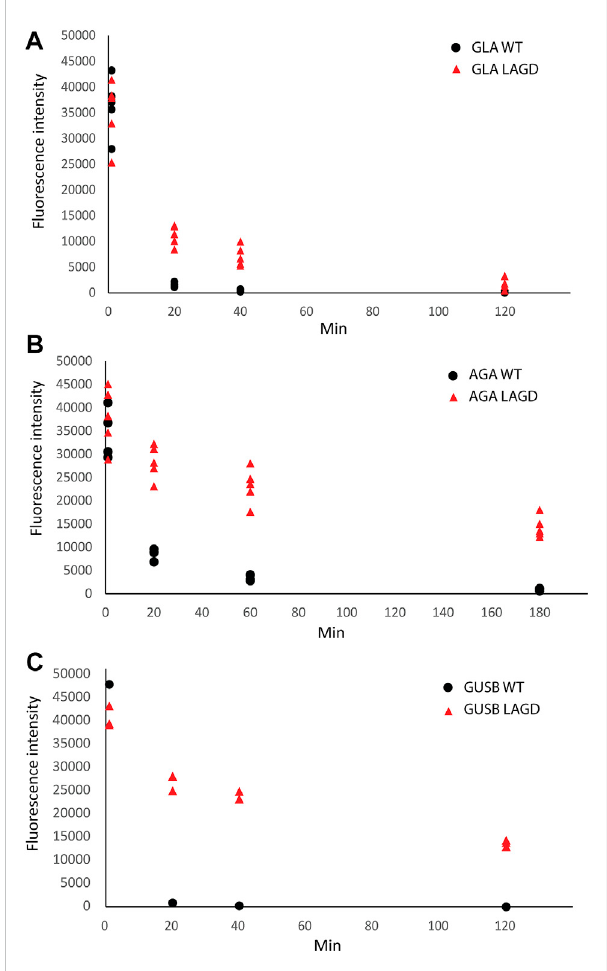
FIGURE 6 PK study of (A) GLA, (B) AGA and (C) GUSB glycovariants in WT mice. Enzyme activities in plasma, represented as relative fl uorescence intensity, after infusion of enzymes are shown. Blood sampleswerecollectedat1,20,40,and120 minafterinjectionof GLA (n = 5 for WT and LAGD) and GUSB (n = 1 and 3 for WT and LAGD, respectively),andat1,20,60,and180 minafterinjectionofAGA(n=4 and 5 for WT and LAGD,